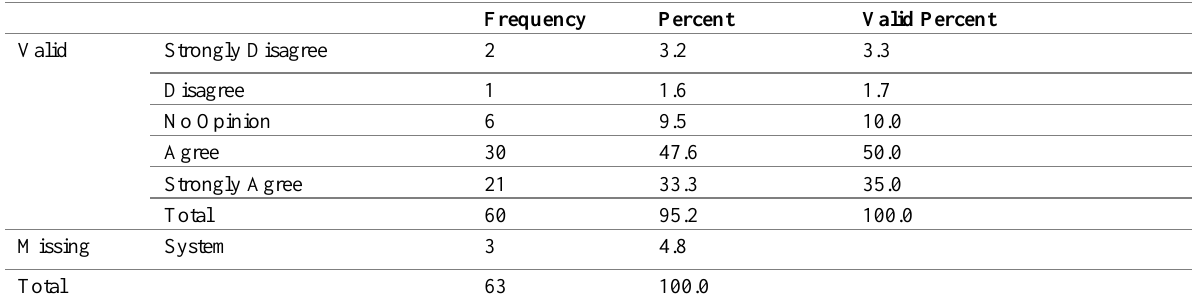
Table 17: Results of Questionnaire Processing That Are Related to Organizational Barrier Rate the management support of your department adopting and implementation of e-government